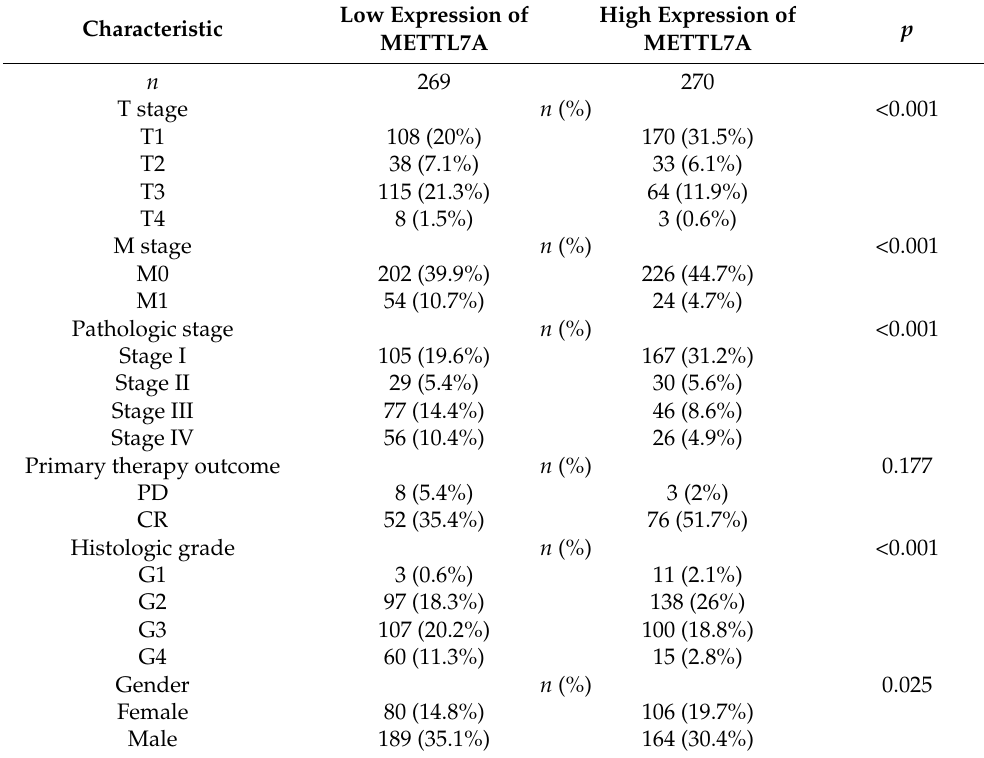
Table 1. Clinical characteristics of KIRC